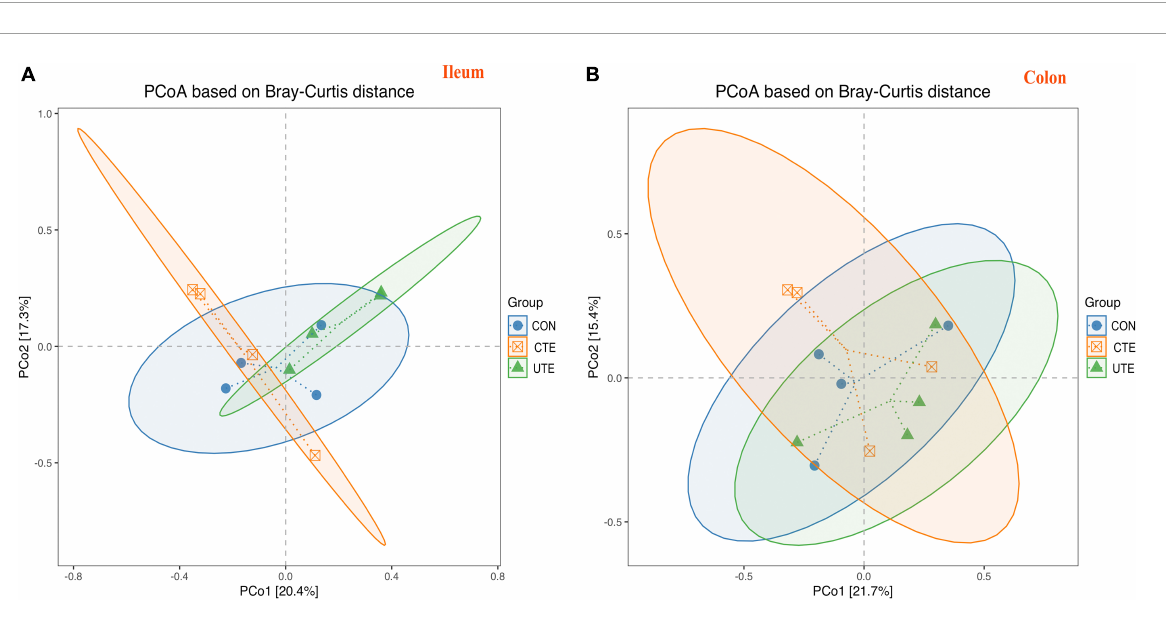
FIGURE5 Bray–Curtis distance matrix PCoA of bacterial samples in the ileum (A) and colon (B) . CON, sheep fed with the basal diets; CTE, sheep fed with the basal diets plus 400 mg/kg coated trace elements; UTE, sheep fed with the basal diets plus an equal amount of trace elements in uncoated form. n =